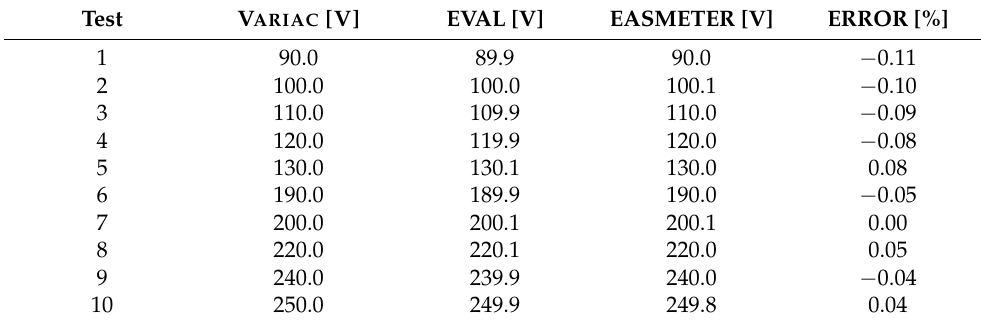
Table 3. Validation of RMS voltage reading.